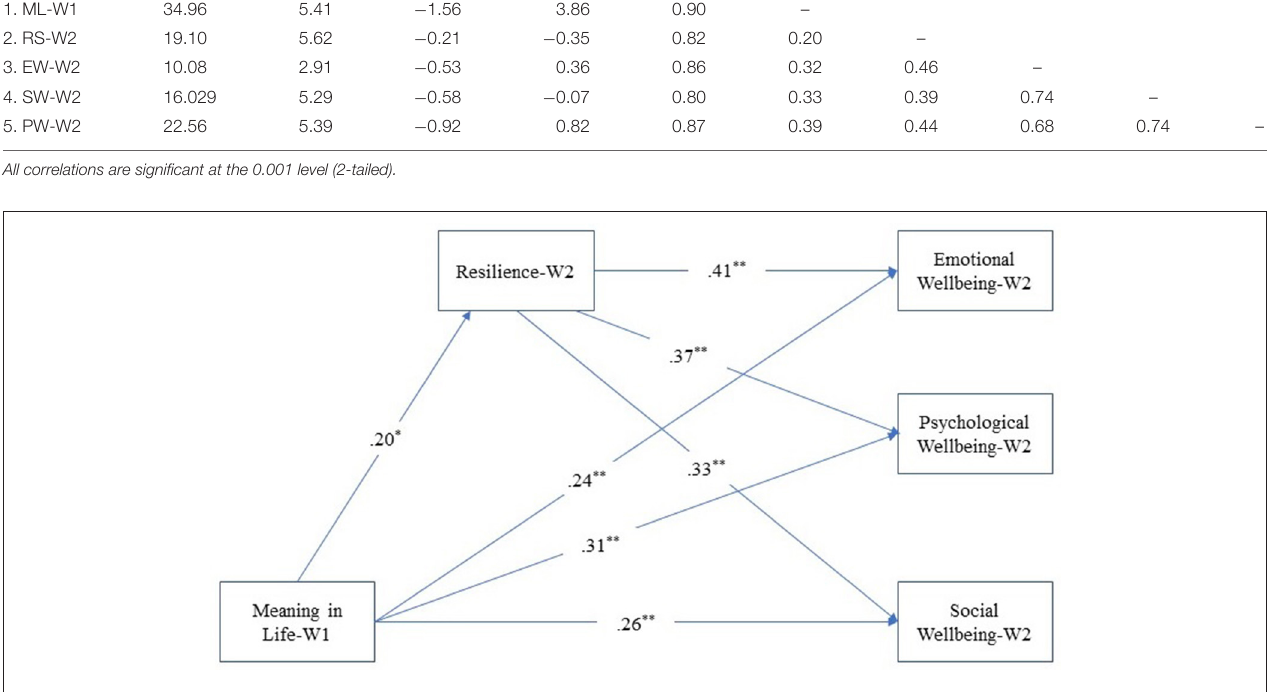
FIGURE 1 | Mediation model indicating the relationships between the variables of the study. * p < 0.05; ** p <